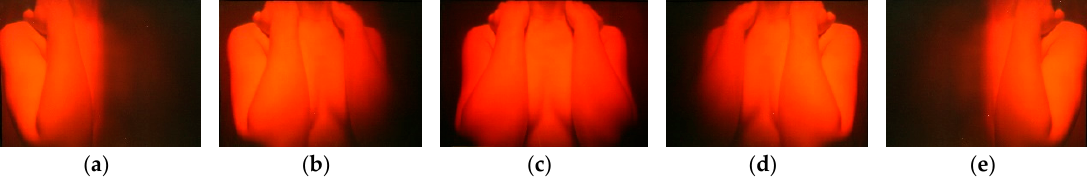
Figure 5. ( a ) 20° to left of center, ( b ) 10° to left of center, ( c ) center, ( d ) 10° to right of center, ( e ) 20° to right of center.